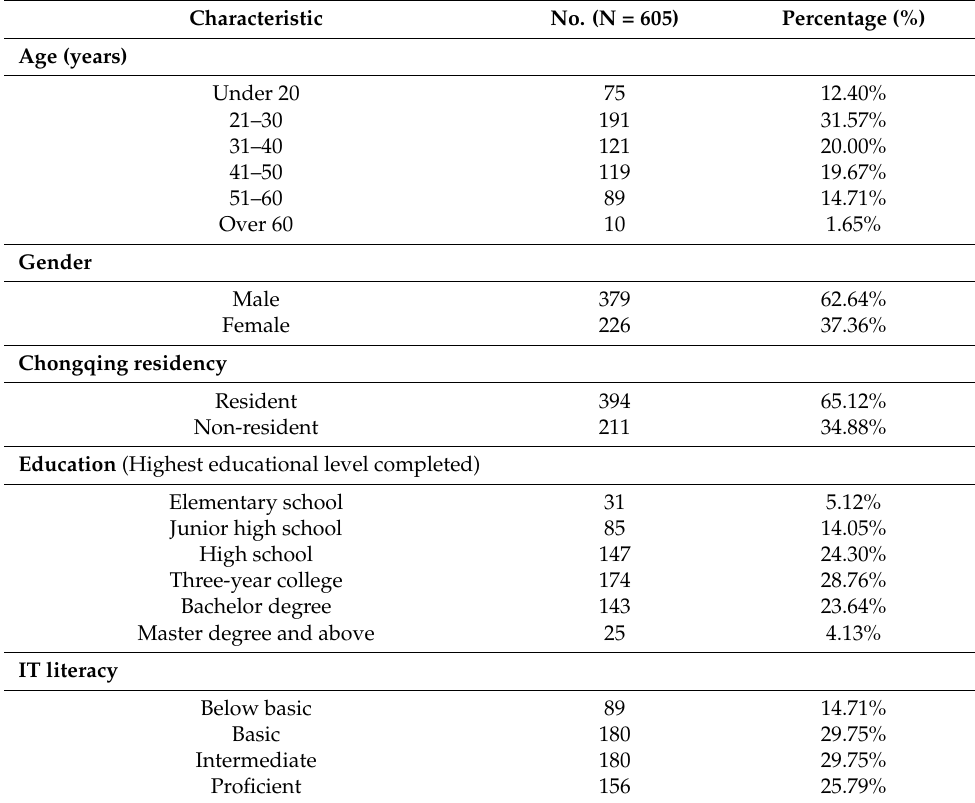
Table 1. Demographic Characteristics.